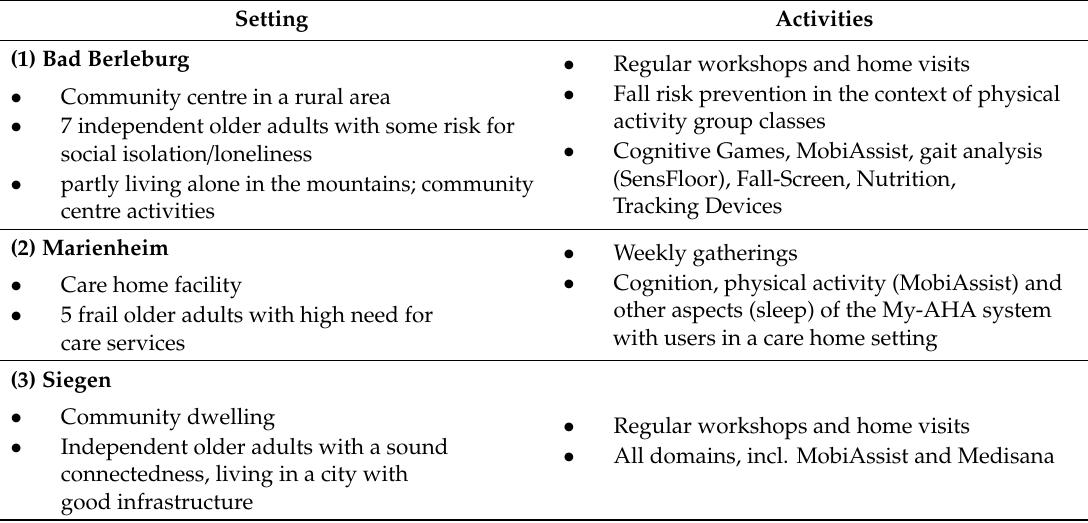
Table 1. Living Lab settings, their users’ living conditions, and their activities.